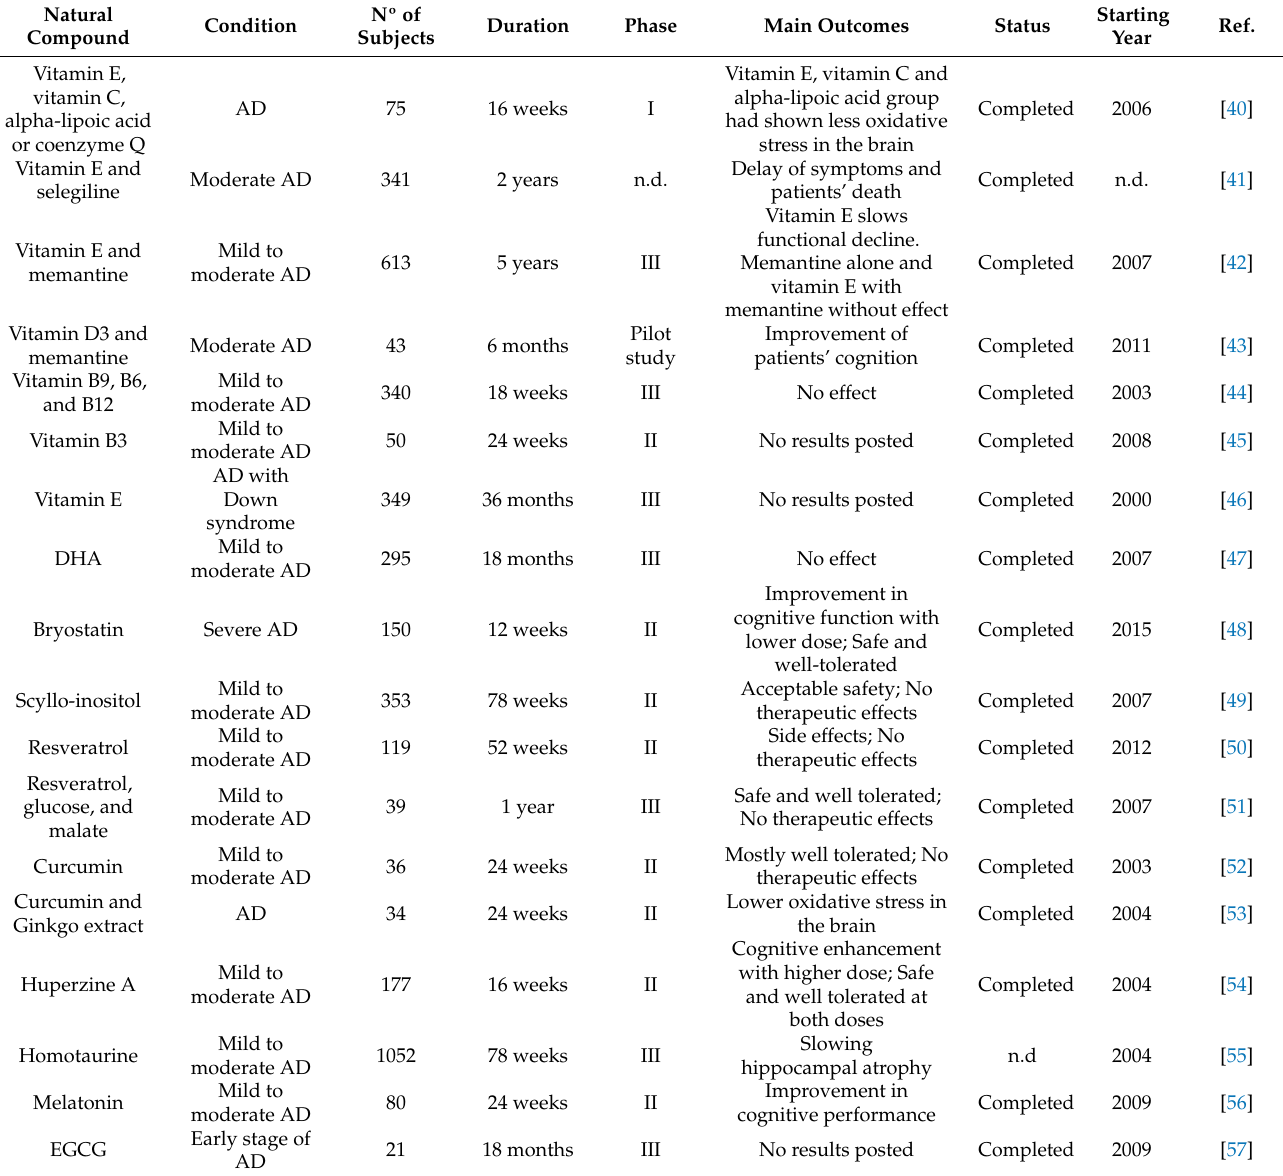
Table 1. Natural compounds in clinical trials for AD